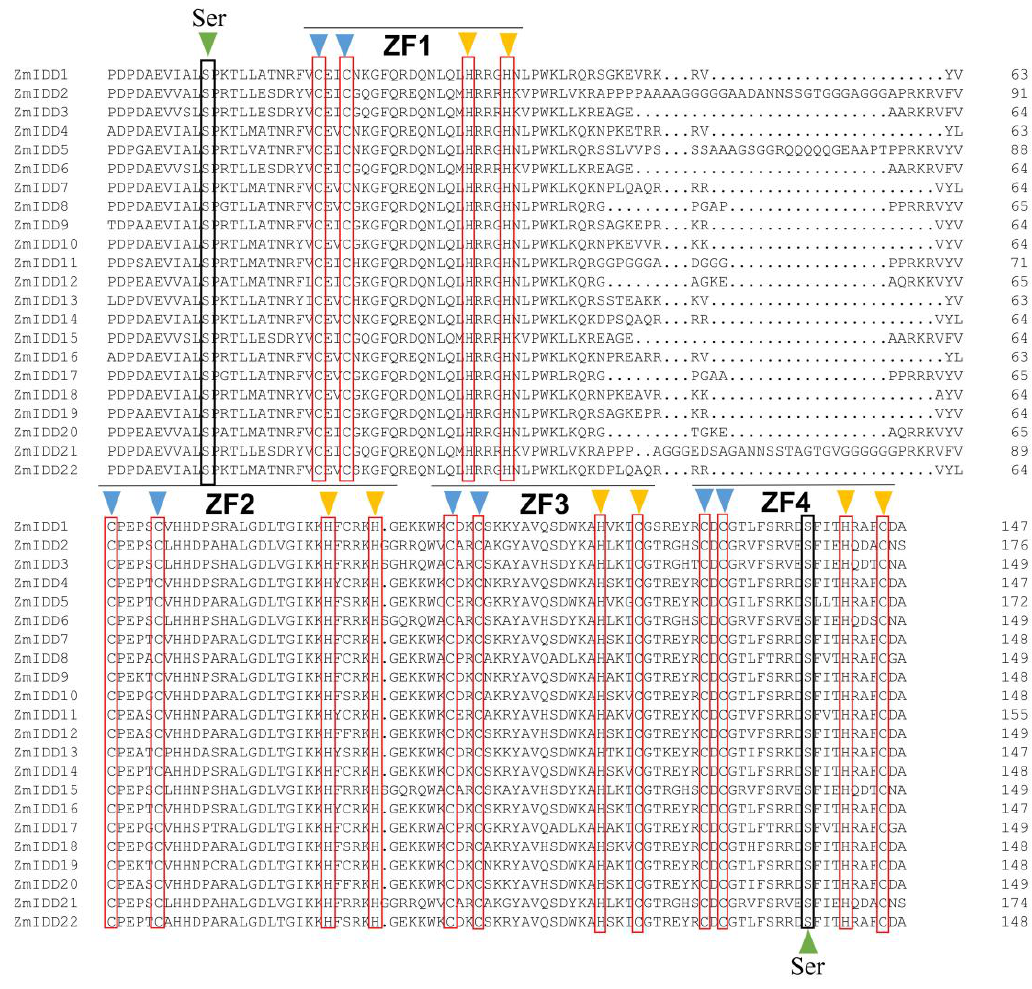
Figure 3. Comparative amino acid sequence alignment of INDETERMINATE DOMAIN (IDD) genes that shows motifs or domains that are conserved in maize. Black boxes mark the positions of cysteines (C, in blue triangles) and histidines (H, in yellow triangles) characterized for each zinc finger.